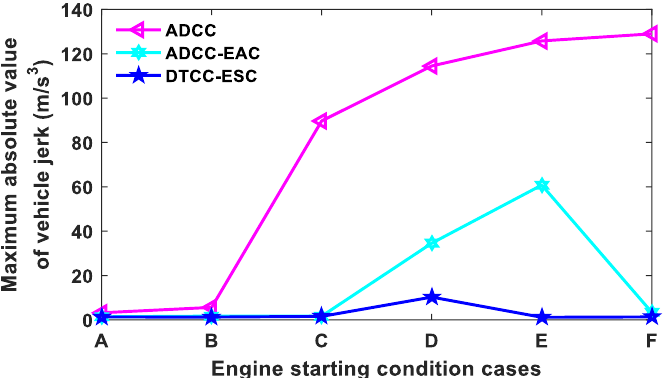
Figure 23. Jerk analysis under six engine starting conditions.